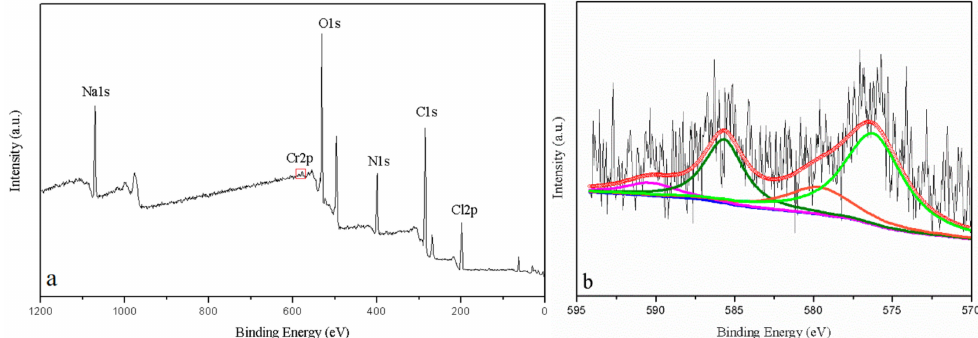
Figure 6. The survey ( a ) and high resolution ( b ) XPS spectra of Cr 2p in EPS. The peaks at 585.7 eV and 576.3 eV can be assigned to Cr 2p 1 / 2 and Cr 2p 3 / 2 for Cr(III) respectively, the peaks at 590.4 eV and 579.8 eV can be assigned to Cr 2p 1 / 2 and Cr 2p 3 / 2 for Cr(VI)